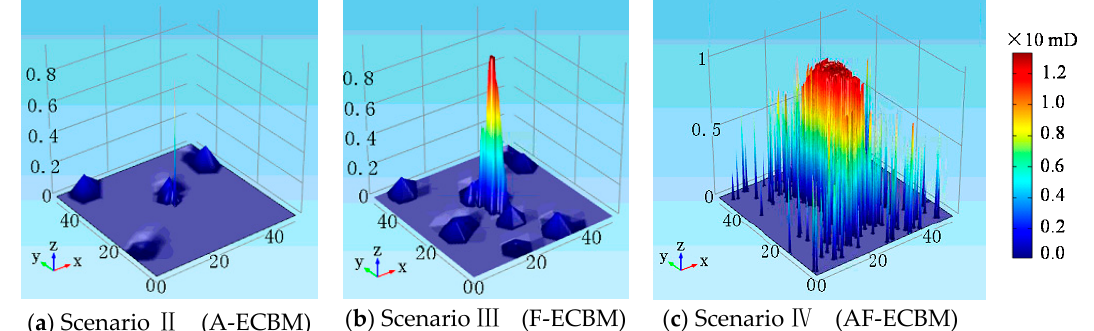
Figure 8. Permeability 3D distribution of different stimulation methods after treated 8000s.